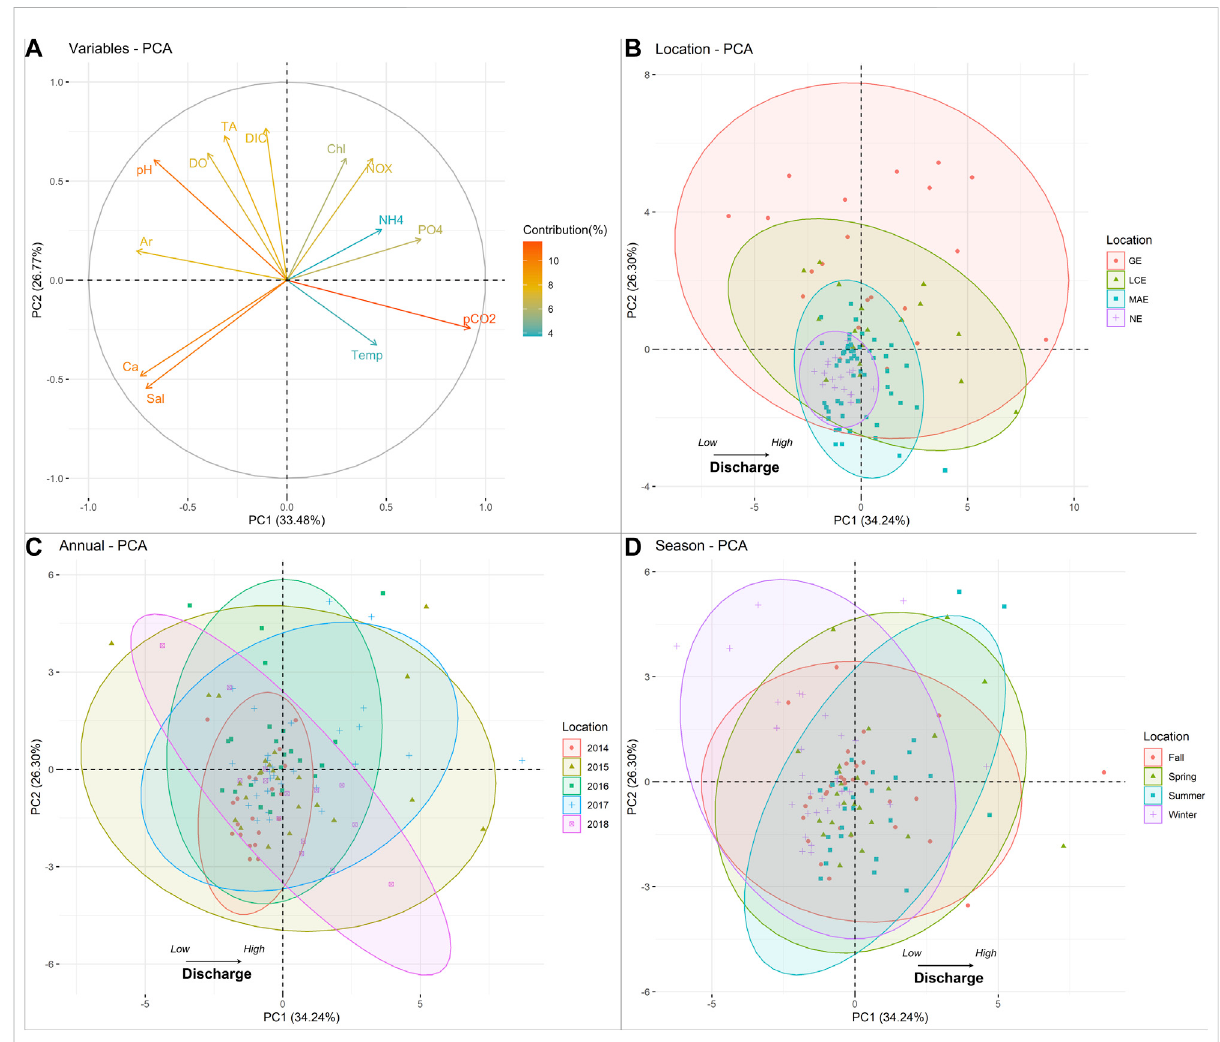
FIGURE 8 PCAanalysisofwaterchemistryinnwGOMestuaries. (A) VariablesloadsforPC1andPC2; (B) principalcomponentofmonthlyvariancebetween estuaries; (C) principal component of monthly variance between sampling years; (D) principal component of monthly variance between seasons. Abbreviations: water temperature (Temp), salinity (Sal), chlorophyll a (Chl), dissolved oxygen percentage (pDO), Ar ( Ω Arag ), Ca ([Ca 2+ ]), ammonium (NH 4 ), nitrate and nitrite (NO X ), and orthophosphate (PO 4